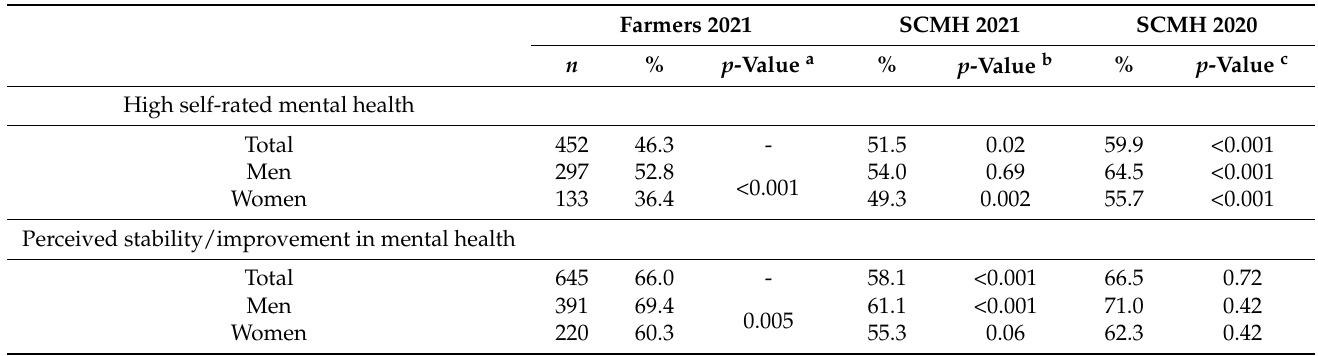
Table 6. Prevalence of high self-rated mental health and perceived stability/improvement in mental health since the pandemic began for the overall 2021 sample and by gender in comparison to the Canadian general population from Statistics Canada’s Survey of COVID-19 and Mental Health (SCMH) cycles 1 (Spring 2020) and 2 (Fall 2021).